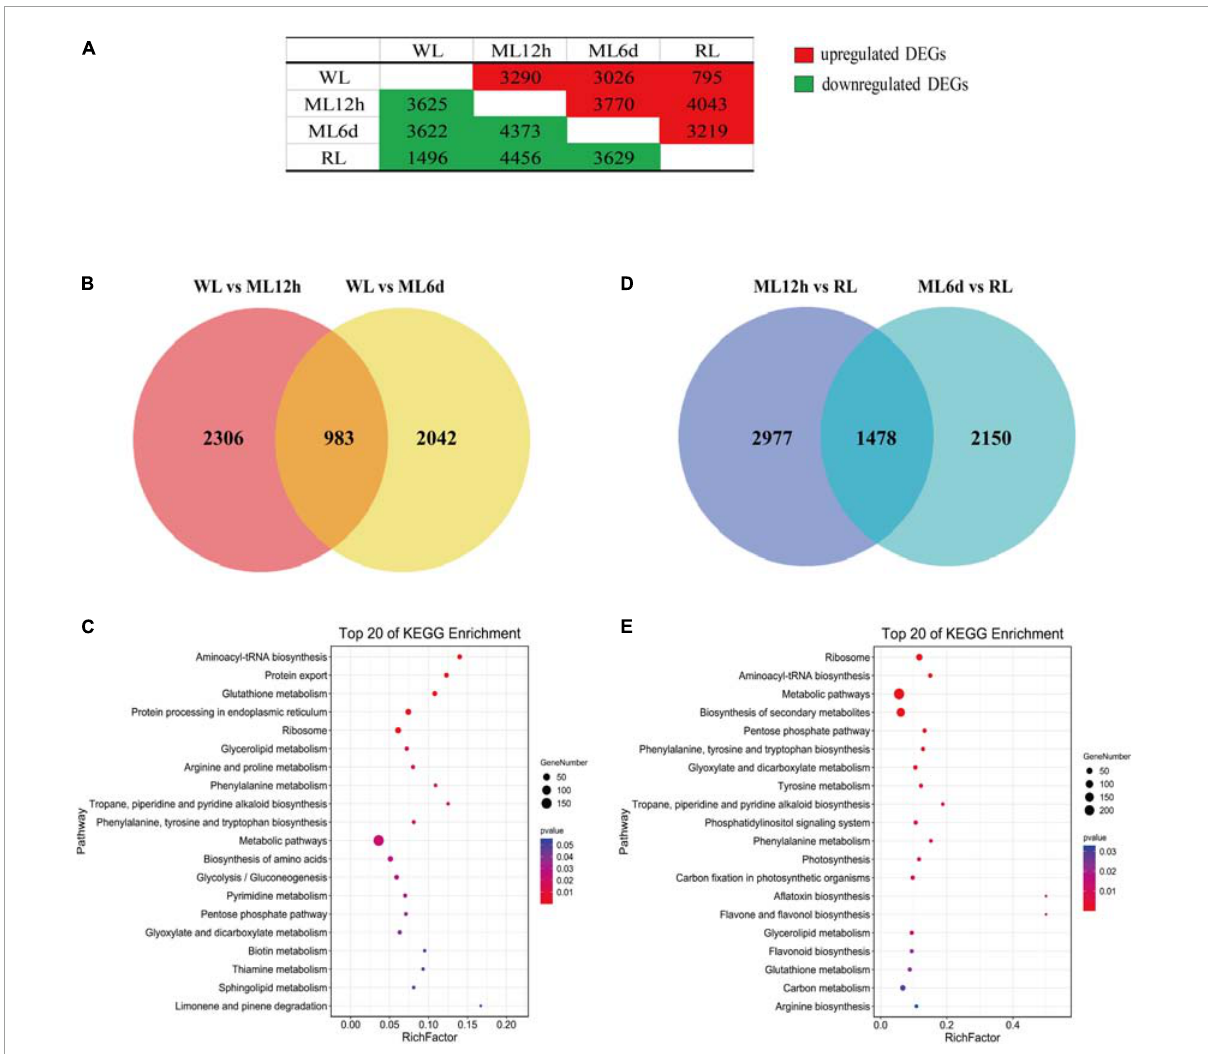
FIGURE3 Venn diagram and KEGG pathways of the DEGs under different light intensity treatments. (A) Number of upregulated and downregulated differentially expressed genes (DEGs) in pair-wise comparisons. (B) Venn diagram and (C) top 20 KEGG pathways of upregulated genes of the ML12h and ML6d groups compared with WL. (D) Venn diagram and (E) top 20 KEGG pathways of downregulated genes in the RL group compared with ML12h and ML6d.